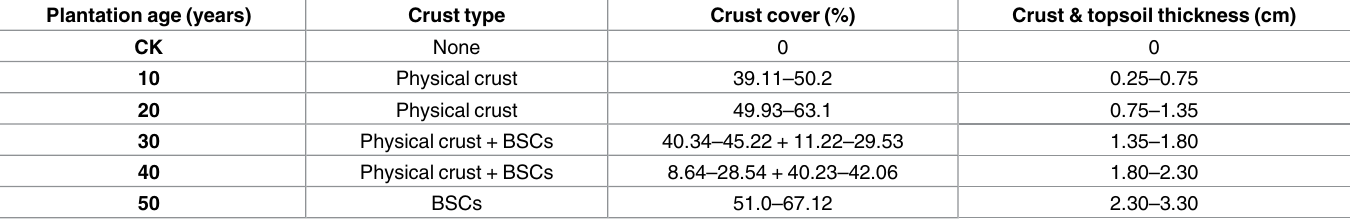
Table 1. Changes in soil crust characteristics on mobile sand dunes (CK) and of H . ammodendron plantations established in each decade over 50 years. Plantation age